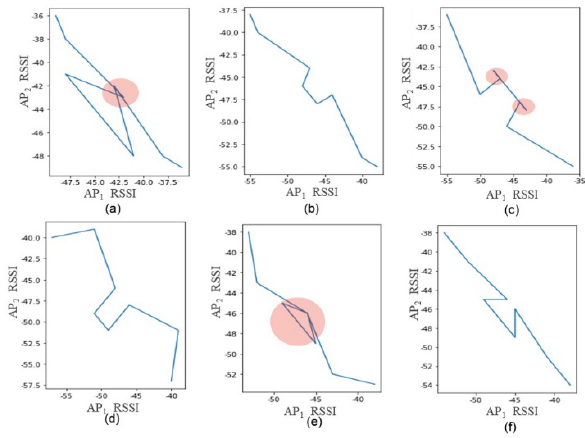
Figure 15(a)~(f). RSSI distributions of AP 2 vs. AP 1 for RSSI profiles shown in Figure 14(a)~(f) Table 4. Confusion matrixfor testing results obtained using RSSI plots in Figure